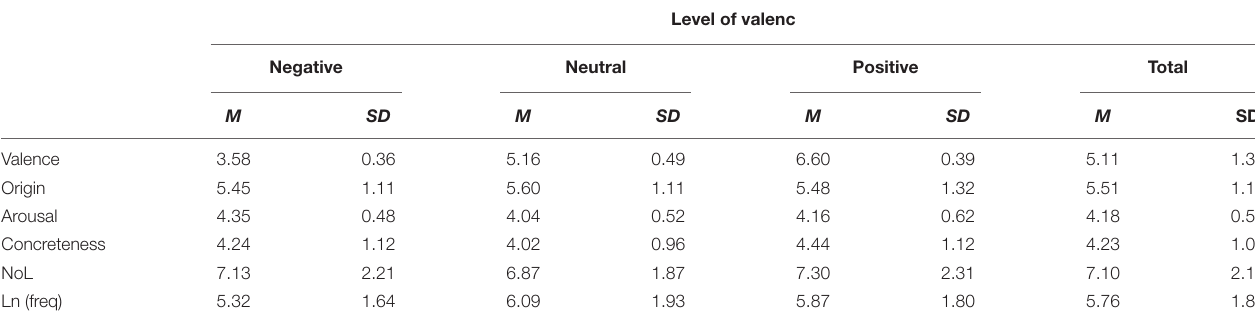
TABLE 1 | Means and standard deviations for all groups of words on the experimental and control